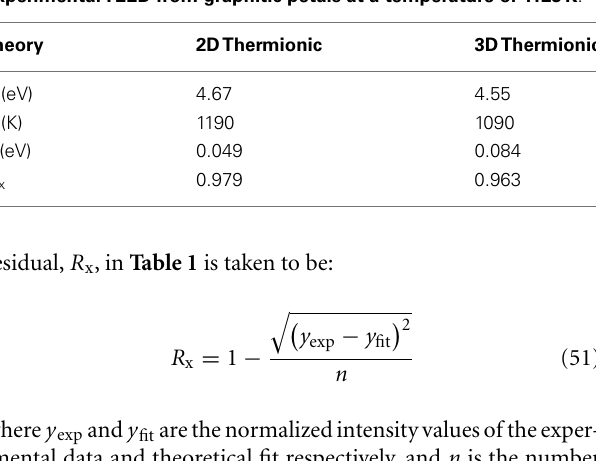
Table 1 | Results from data fitting of thermionic theory to an experimentalTEED from graphitic petals at a temperature of 1123K